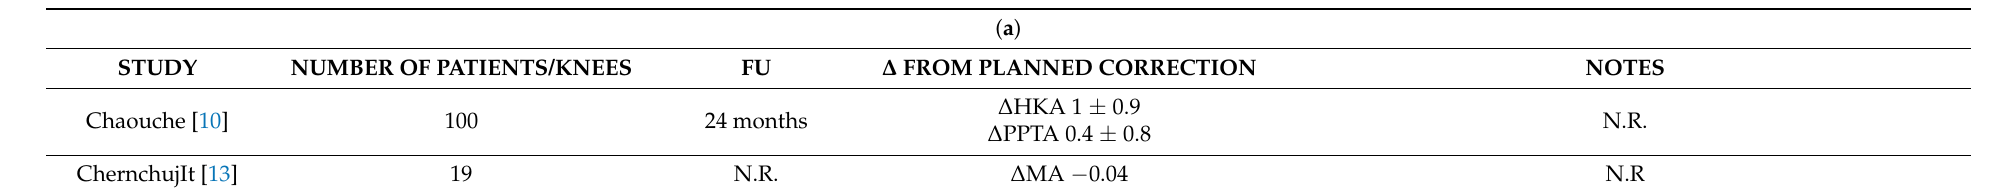
Table 2. (a) In Vivo Studies; (b) In Vivo Comparative